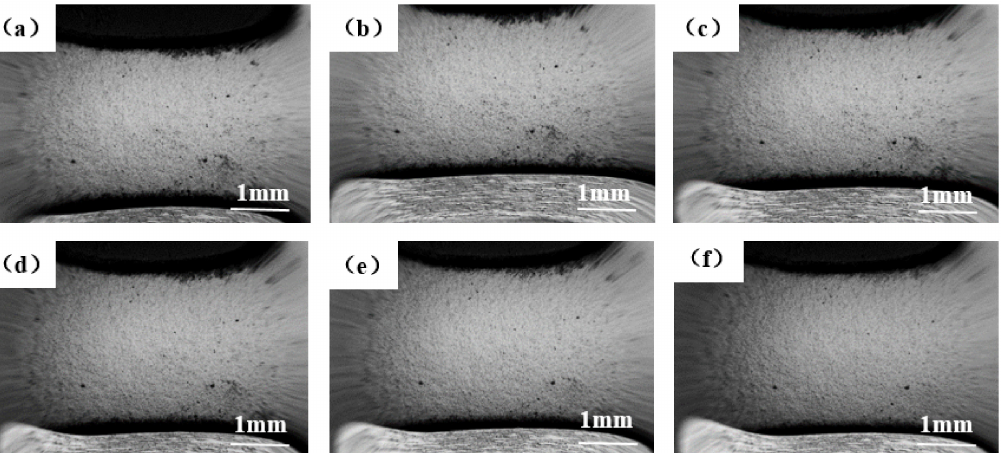
Figure 6. In situ SEM of a sample held at 766 ◦ C and subjected to a variable loading profile: ( a ) 10 N;